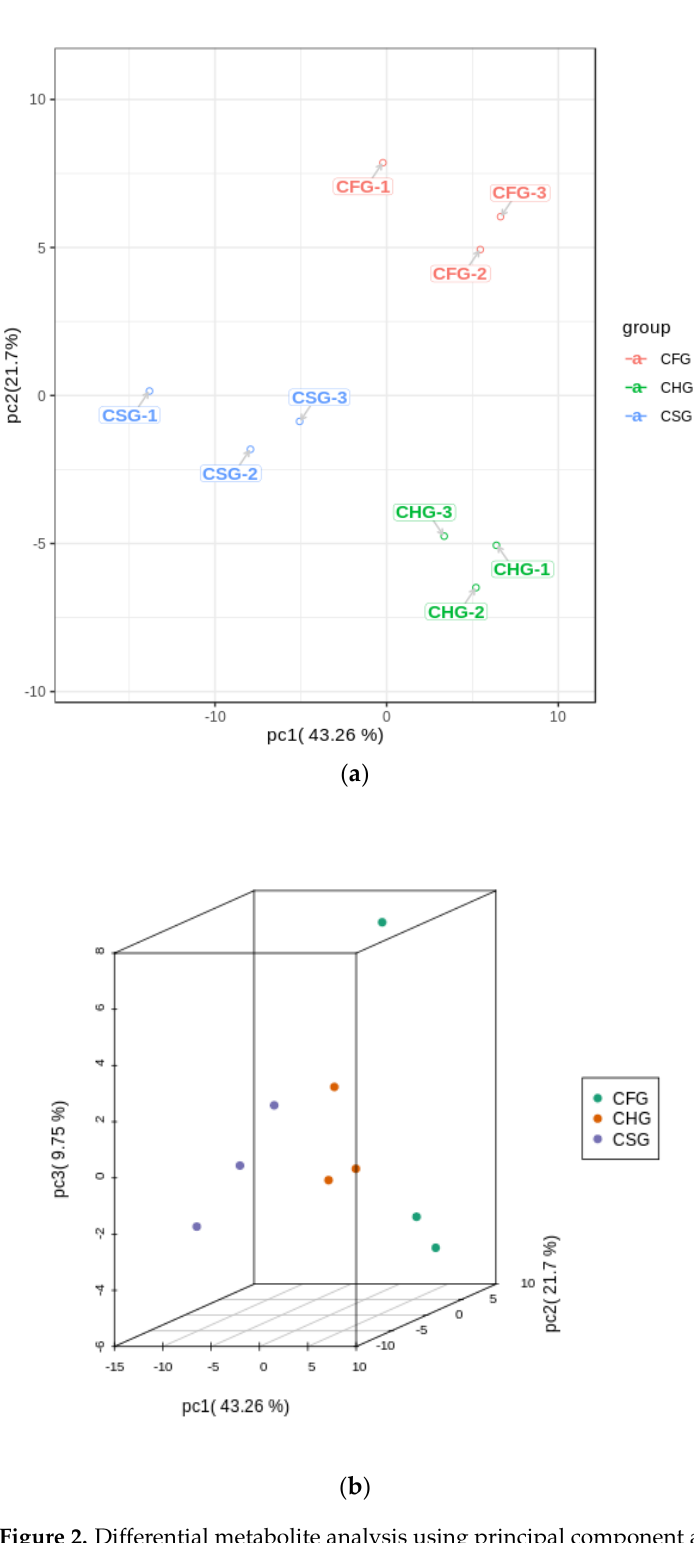
Figure 2. Differential metabolite analysis using principal component analysis (PCA). ( a ) 2D figure; ( b ) 3D figure.